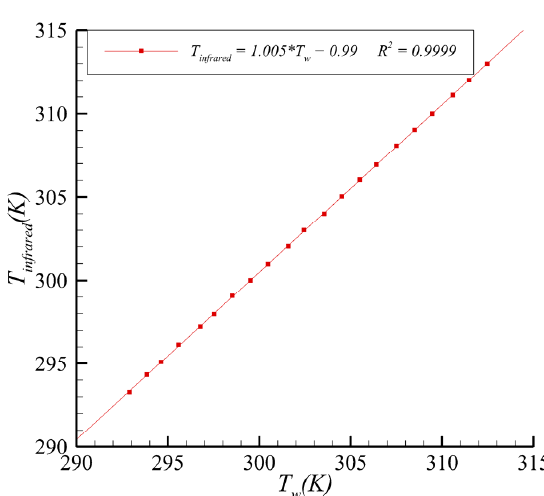
Figure 4. Calibration curve of infrared camera.